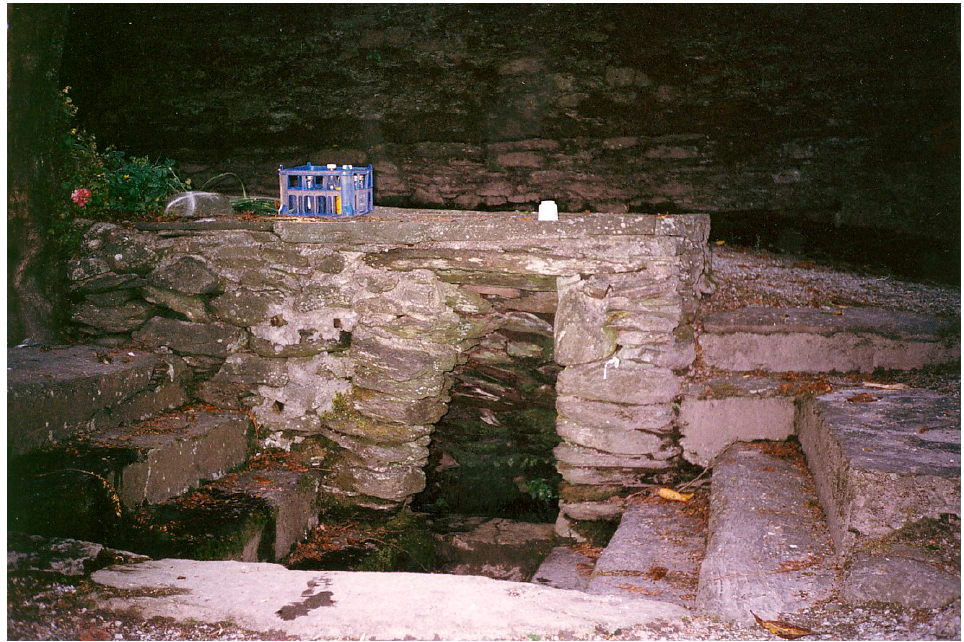
Figure 5. St. Gobnait’s Well,